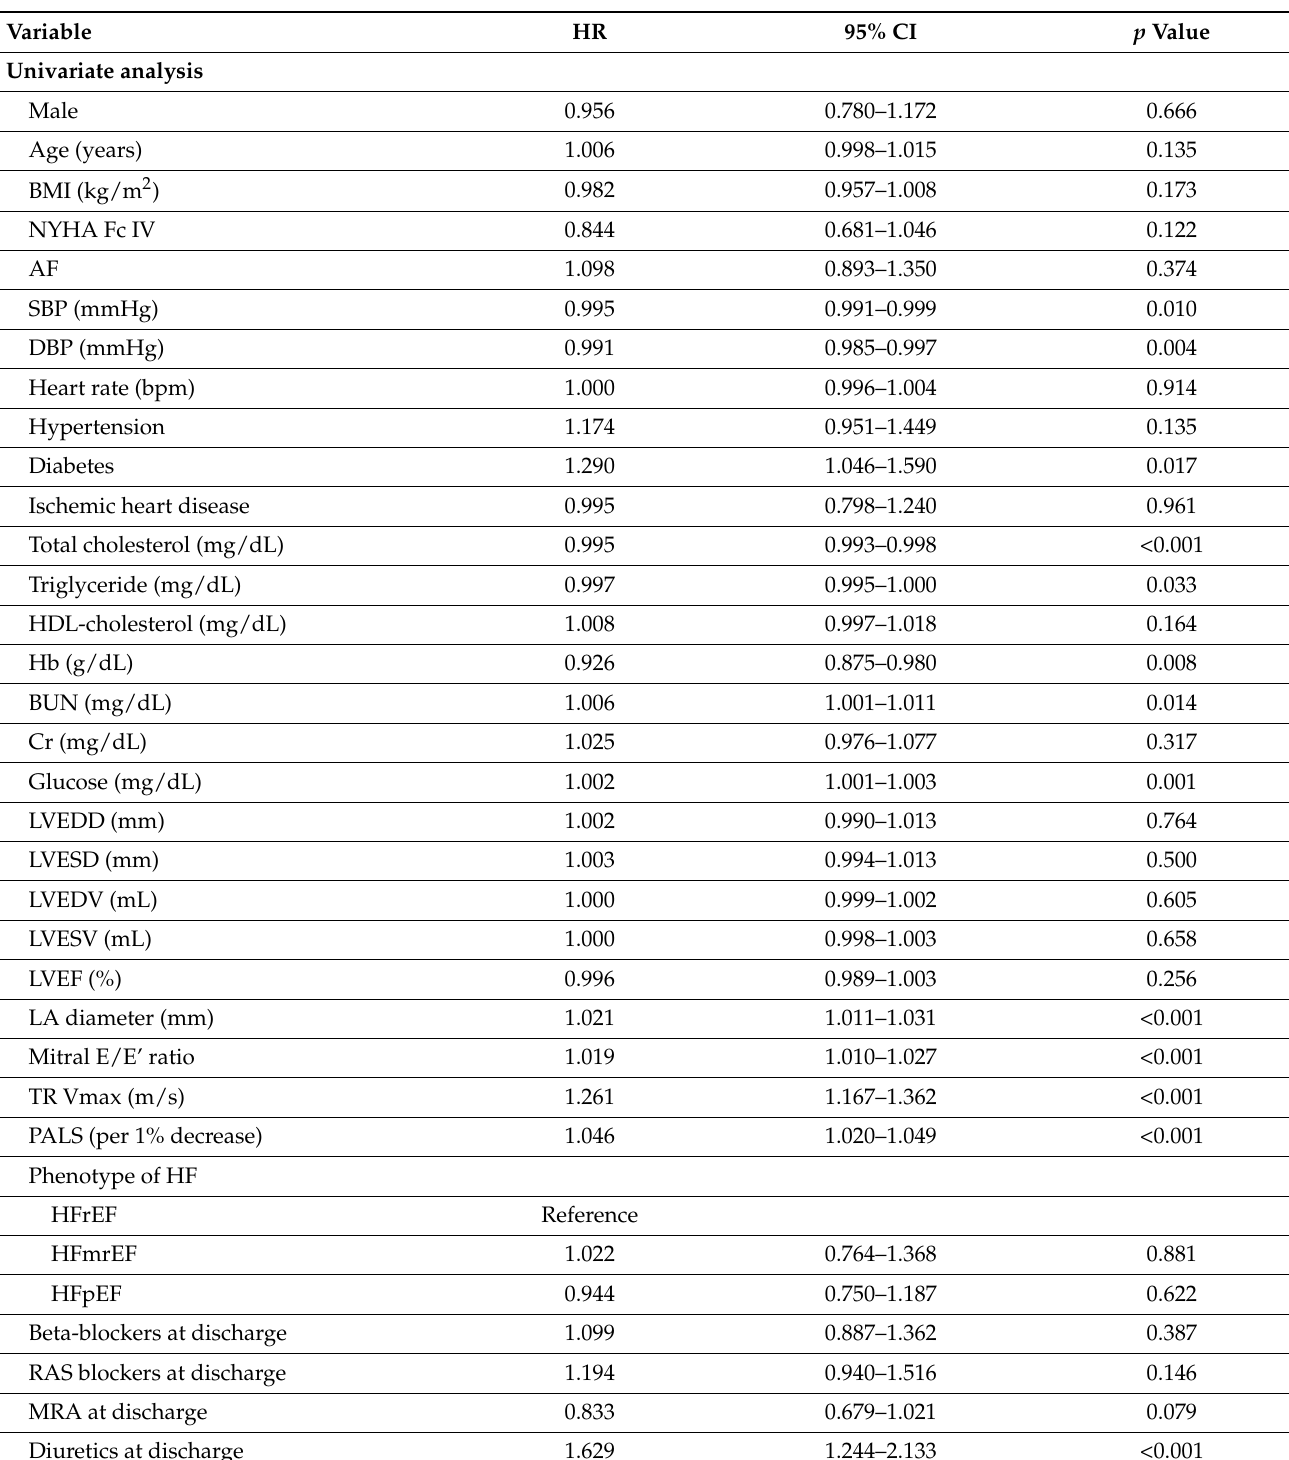
Table 2. Univariate and multivariate analysis of the prediction of pulmonary hypertension at follow- up